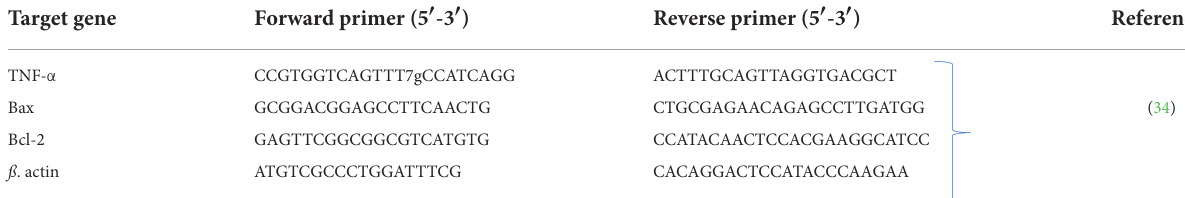
TABLE 1 Sequences of primers utilized in